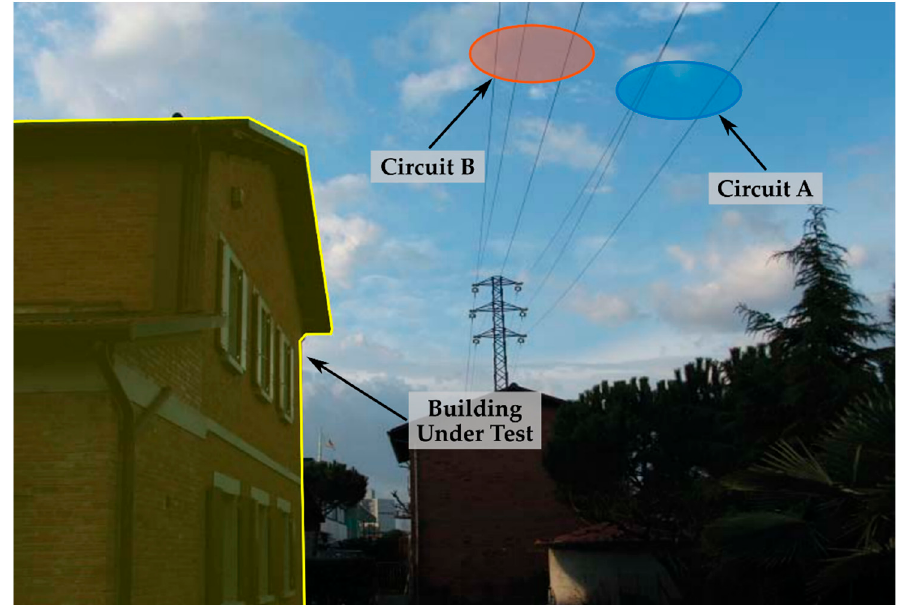
Figure 2. Building under test in front of the double-circuit medium voltage line.